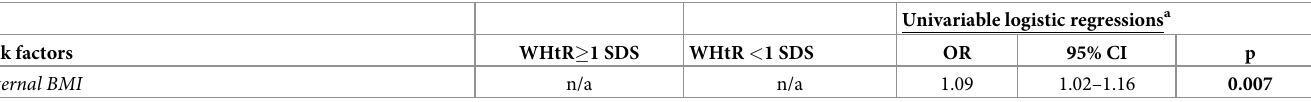
a The logistic regressions included each of the independent variables separately. Among risk factors related to nutrition- and feeding practices, breastfeeding and bottle feeding at 0–1, 3–4, 6, 12, 18 and 24 months and milk cereal drink consumption at 6, 12, 18 and 24 months were investigated, but significant associations with an elevated WHtR SDS at five years of age were only found for milk cereal drink consumption at 24 months and bottle feeding at 12 and 24 months. A p-value < 0.05 was considered significant.